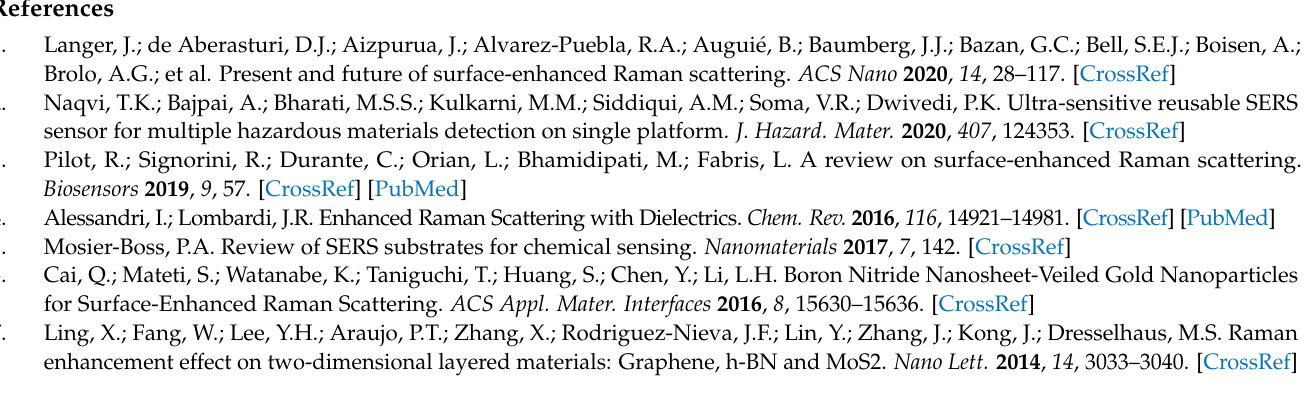
for growth of hBN film. Figure S3: (a and b) Thickness measurement of 1.5 nm and 6 nm. Figure S4: XPS Survey spectrum of 6 nm hBN film. Figure S5: UV-Visible spectrum of the transferred film, Inset- Tauc’s plot showing band gap of 5.7 eV. Figure S6: Repeatability study with the 7 nm film—Raman enhancement of 1 µ M MB by a different 7 nm film at different positions. *50 mW laser power, 532 nm laser, 100 × objective, integration time—5 s, Accumulation time—2. Figure S7: (a) Raman spectrum 1 µ M MG/6 nm hBN/SiO2/Si (b) Raman spectrum 50 µ M R6G/6 nm hBN/SiO2/Si (c) Raman spectrum of 1 µ M MB /7 nm hBN film after cleaning in ethanol for 45 min at 10 positions. Apart from the hBN and Si peak no other peak can be seen. * For all the Raman measurements in this slide—532 nm excitation, 100 × objective, integration time—5 s, Accumulation—2, input laser powers of 100 mW for (a) & (c) and 25 mW were used for the data presented in (b). Figure S8: Raman enhancement of 1 micro molar MB with Au nano particles and hBN 633 nm excitation with 10 mW. Figure S9: (a) Raman spectrum of the 1 µ M MB/6 nm hBN after washing in ethanol for 45 min. (b) Re-drop casting 1 µ M MB over the film in (a). Clearly regeneration has been achieved. Figure S10: Full view of the optimized geometries of complexes of a single layer of hBN and dye (a) methylene blue (MB), (b) Rhodamine 6 G (R6G) and malachite green (MG). Figure S11: Full view of HOMO electron density surfaces for isodensity value of 0.007 a.u. of the optimized geometries of complexes of a single layer of hBN and dye (a) methylene blue (MB), (b) Rhodamine 6G (R6G) and malachite green (MG). Table S1: Interaction energies of MB, R6G and MG with hBN. Table S2: Comparison of Raman enhancement of hBN films with other 2D